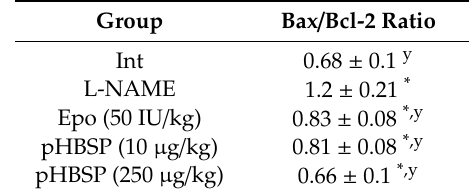
Figure 4. The level of Bax ( А ) and Bcl-2 ( В ) expression in animals with ADMA-like preeclampsia ( n = 10 animals in each group).